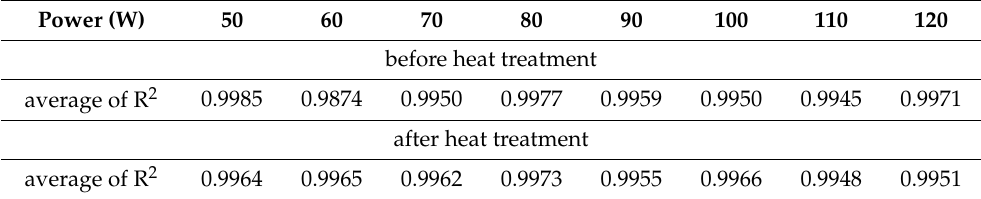
Table 1. Linearity of temperature sensing layers at specific